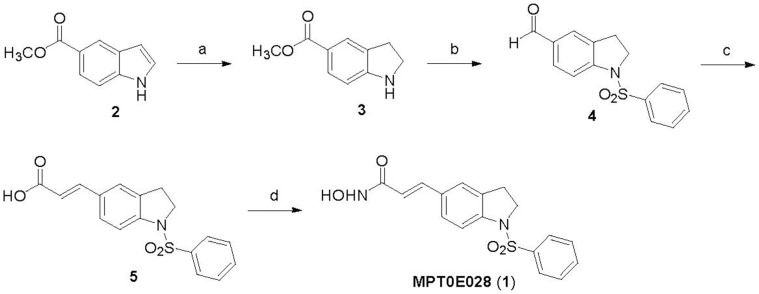
The synthesis of MPT0E028. Reagents and conditions.(a) NaBH3CN, AcOH, 0°C–r.t.; (b) (i) benzenesulfonyl chloride, pyridine, reflux; (ii) LiAlH4, THF, 0°C–r.t.; (iii) pyridinium dichromate (PDC), molecular sieves, CH2Cl2, r.t.; (c) (i) methyl(triphenylphosphorylidene)acetate, CH2Cl2, r.t.; (ii) 1 M LiOH(aq), dioxane, 40°C; (d) (i) NH2OTHP, PYBOP, Et3N, DMF, r.t.; (iii) trifluoroacetic acid, CH3OH, r.t. Abbreviations: NaBH3CN, sodium cyanoborohydride; AcOH, acetyl acid; LiAlH4 (LAH), lithium aluminium hydride; THF, tetrahydrofuran; PDC, pyridinium dichromate; NH2OTHP, O-(tetrahydro-2H-pyran-2-yl)hydroxylamine; PYBOP, benzotriazol-1-yl-oxytripyrrolidinophosphonium hexafluorophosphate; Et3N, triethylamine; DMF, dimethylformamide; TFA, trifluoroacetic acid.